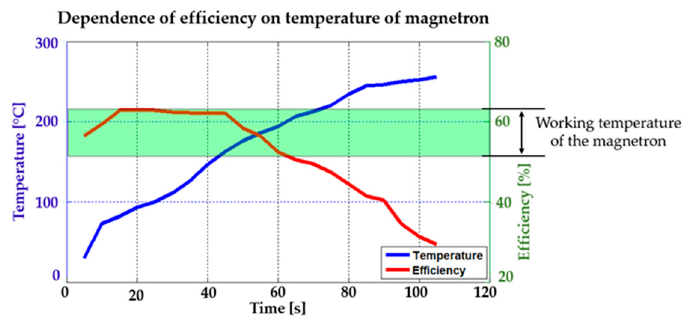
Figure 28. Efficiency against the Magnetron temperature.